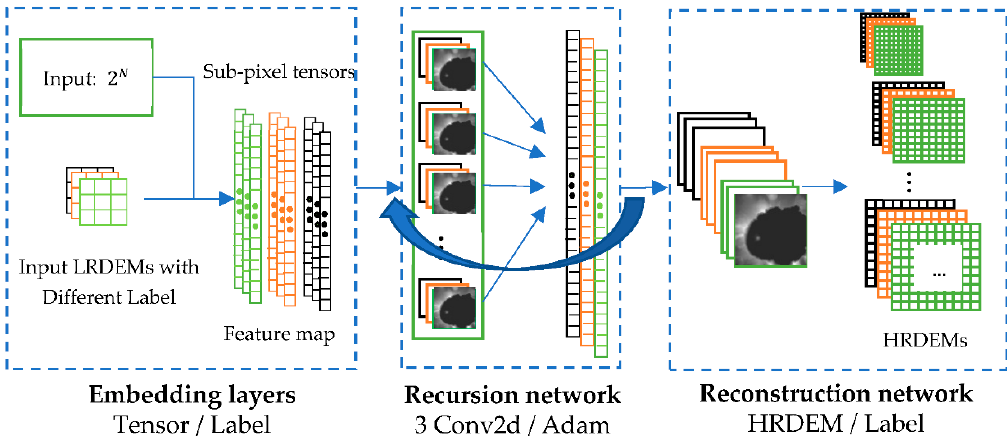
Figure 9. Architecture of RSPCN. It consists of three nets: embedding net, recursion net and reconstruction net. The recursion net is unfolded in Figure 7, as mentioned above.